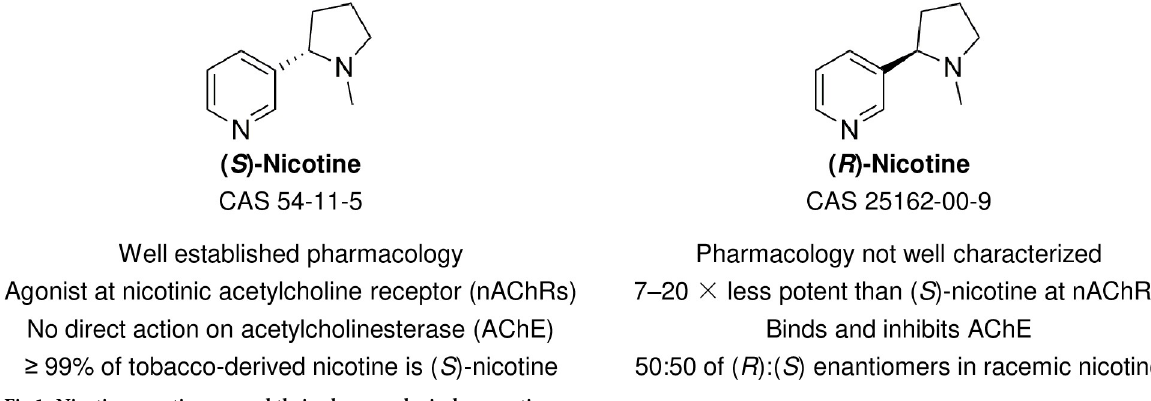
Fig 1. Nicotine enantiomers and their pharmacological